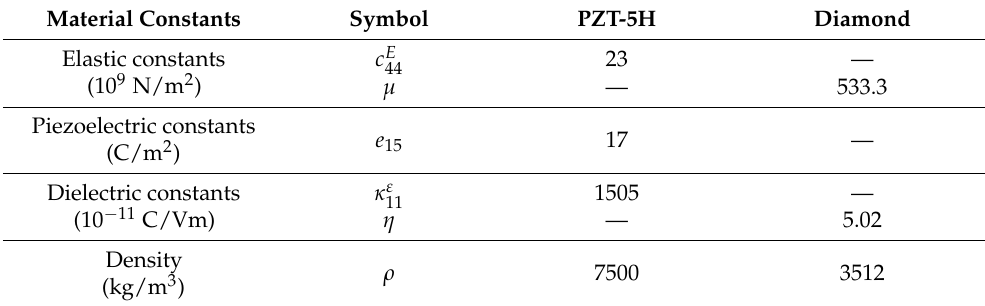
Table 1. Material constants of PZT-5H and diamond used for the numerical calculation [23,24].